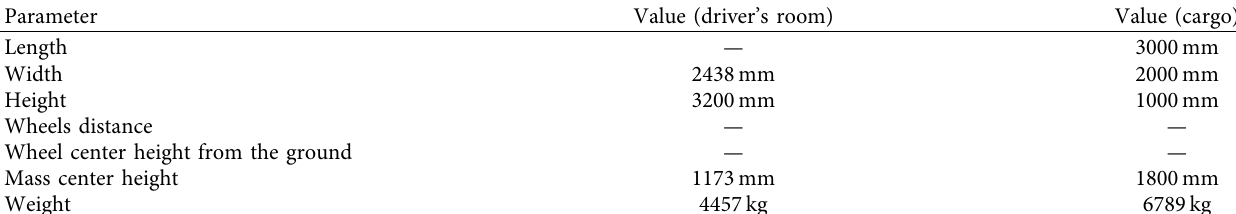
Table 4: Specifcations of E-class SUV.